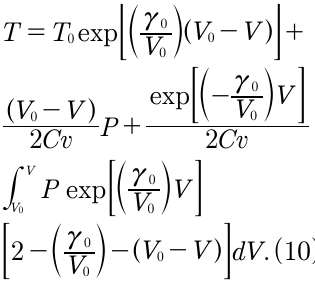
According to the values displayed on literature 28 , a temperature of the order of 1,600 K is estimated for the TNT detonation, and about 2,500 K for the detonation of the Composition B explosive. Such values of pressure and temperature, even for the TNT and Composition B explosives, achieved the diamond region on the carbon phase diagram presented in Figure